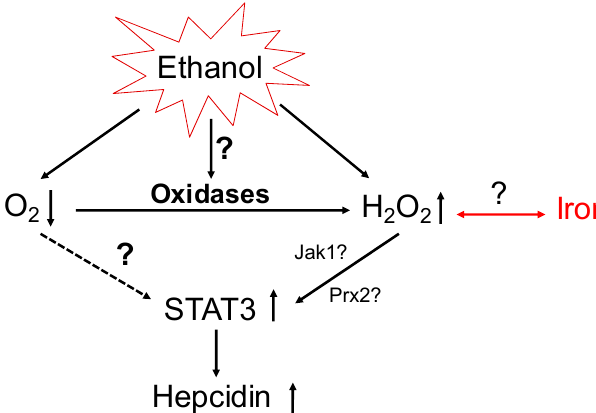
Figure 6. Role of oxidases in regulating hepcidin via hypoxia and H 2 O 2 generation. The novel concept postulates that oxidases are involved in hepcidin regulation and alcohol-mediated hepatic iron overload. It remains to be studied whether this concept also explains iron-sensing of hepcidin (marked in red), which is still insufficiently understood. Jak1: Janus kinase 1.